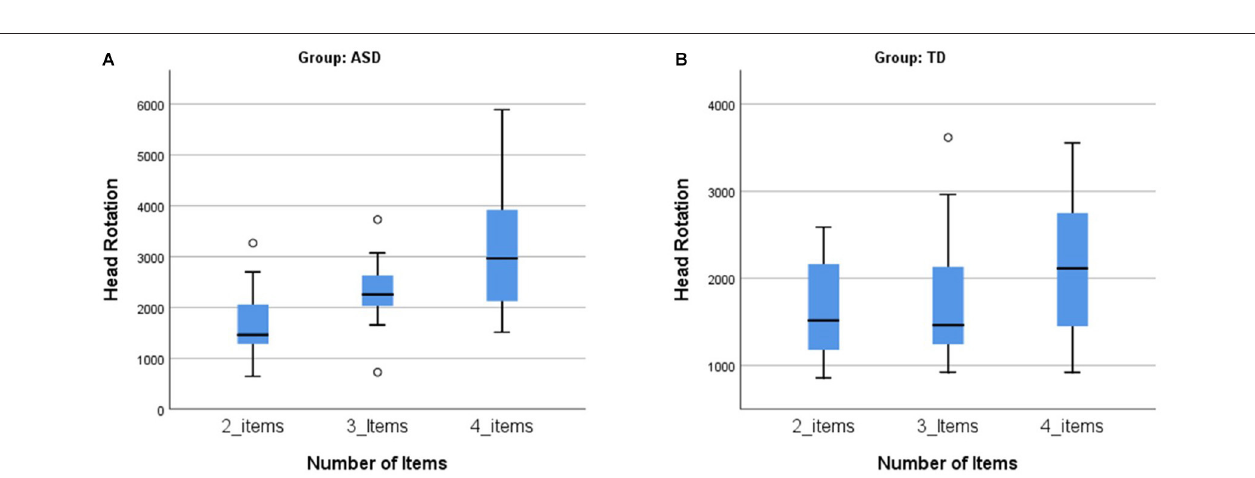
FIGURE 3 | Trend analysis of the number of items: head rotation. (A) The association between the head rotations with the increasing number of items in the ASD group. The head rotations increase with the increment of cognitive load (with higher number of items per condition) in the ASD group. (B) No association between the numbers of head rotations with the increasing number of items in the TD group. In the TD group, the head rotations are similar in the different conditions, despite the increasing number of items (cognitive load). ASD, autism spectrum disorder group; TD, typical neurodevelopment